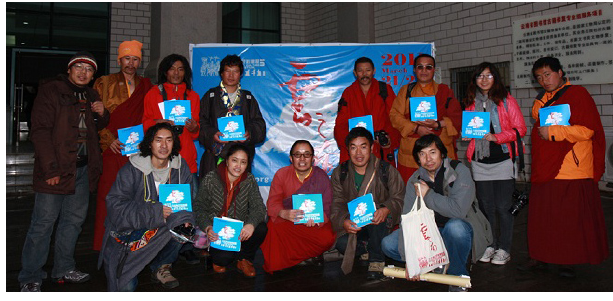
Fig. 5 . Villagers together with Shanshui staff brought their films to the Yunnan Multi Culture Visual Festival in 2011. (Photo by Lu